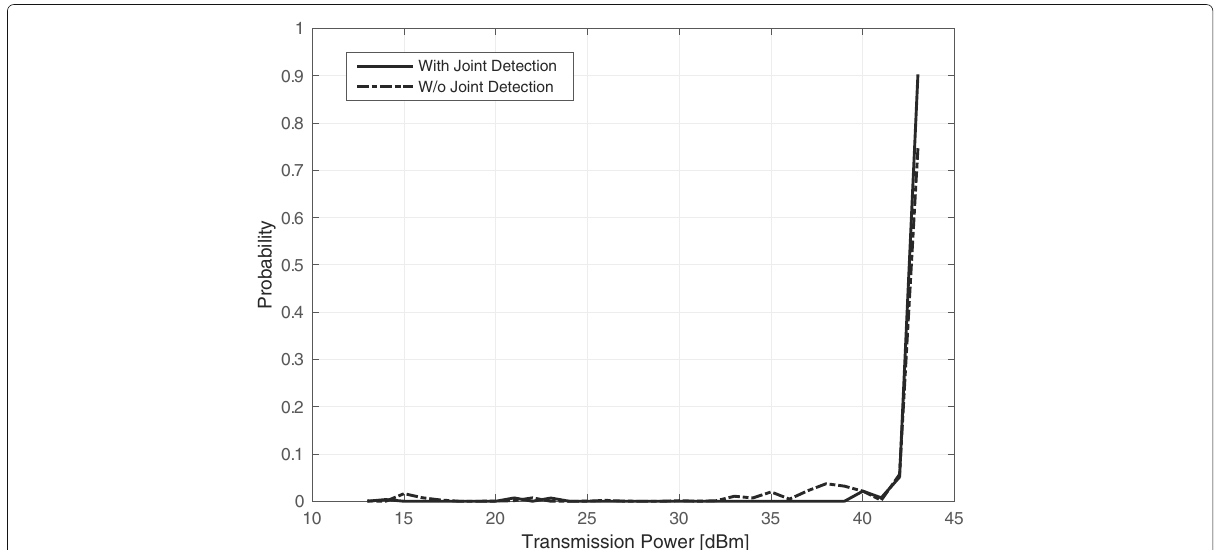
Fig. 13 Probability distribution of MBS transmission power (20 users/sector, PBS: 2(cell